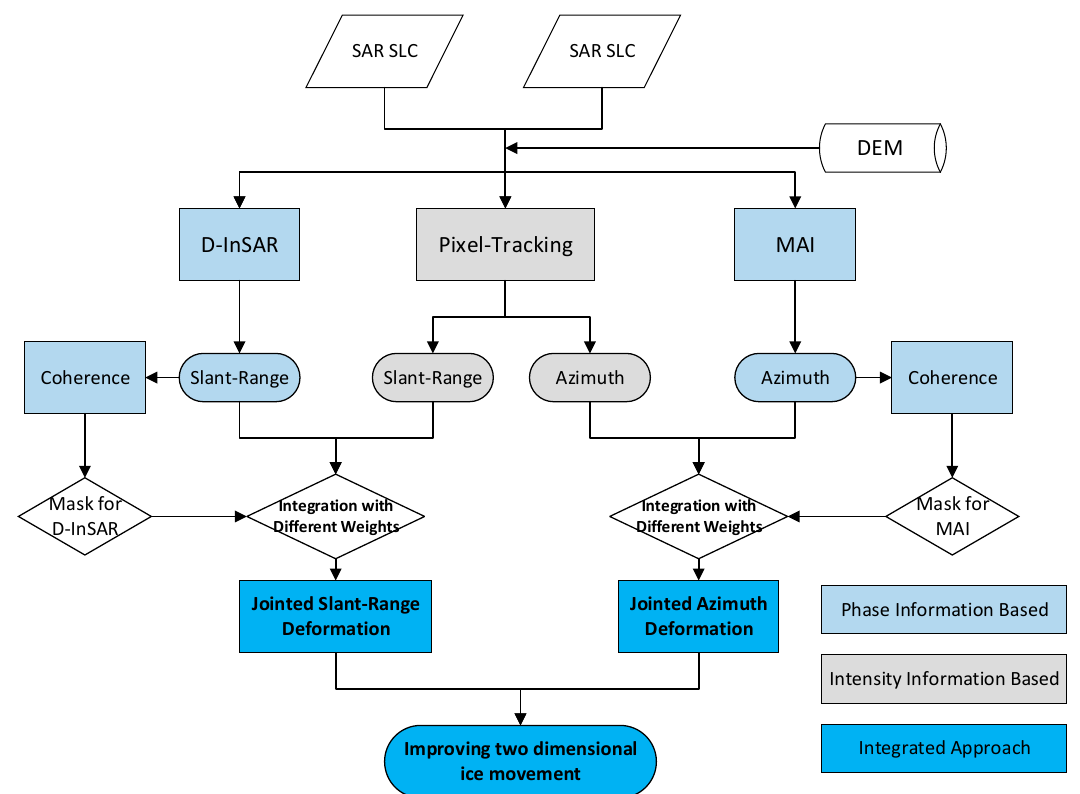
Figure 2. The data processing flowchart of the integrated method.